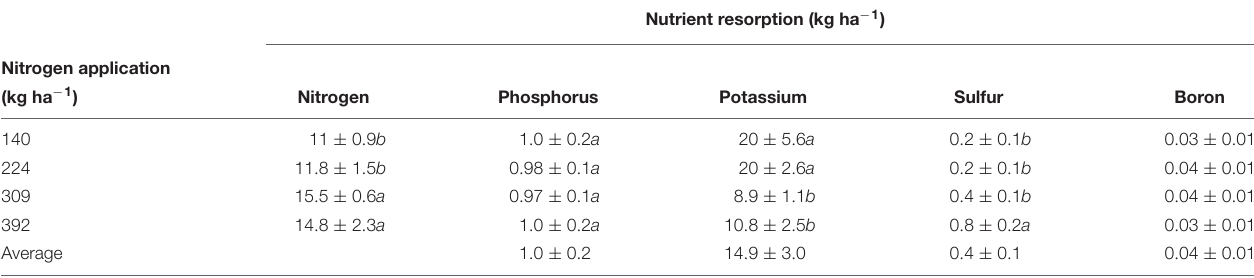
TABLE 8 | Resorption of N, P, K, S, and B (kg ha − 1 ) from leaves to the storage pool under different nitrogen application rates, calculated as the difference between leaf nutrient content at harvest and at leaf senescence.